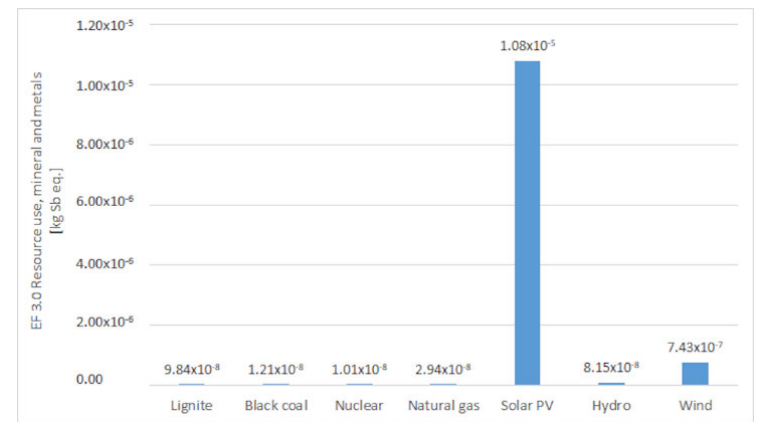
Figure 6. Environmental impacts of selected energy sources on the resource use, mineral and metals category. The results relate to 1 kWh of electricity supplied to the grid. The results are expressed in kg of antimony equivalent.